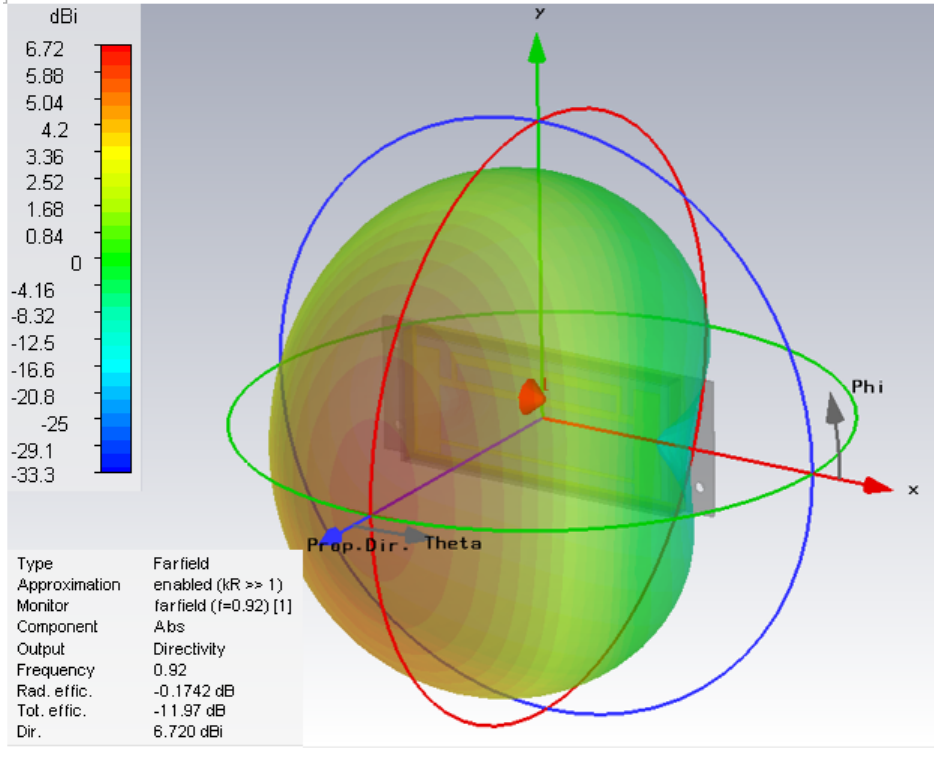
Figure 11. Simulated 3D radiation pattern.